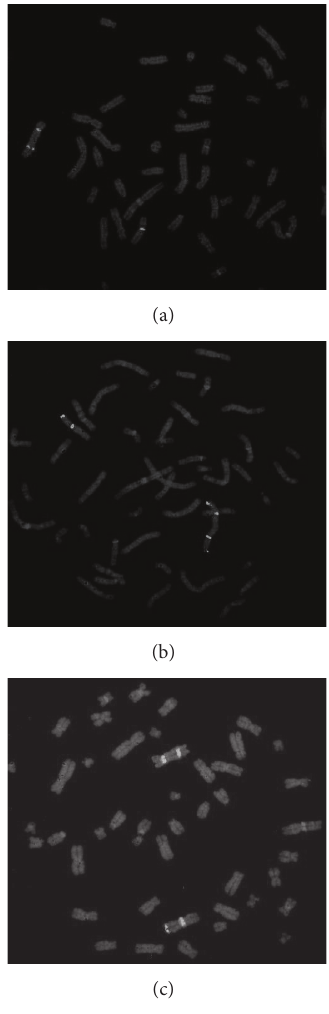
F 4: FISH images: (a) Aqua probe for X centromeres that demonstrates an X isodicentric subpopulation. (b) Two Orange/Green signals for Xp extremity on the isodicentric X (with two Aqua signals). (c) No Orange/Green signals for Xq in the isodicentric X